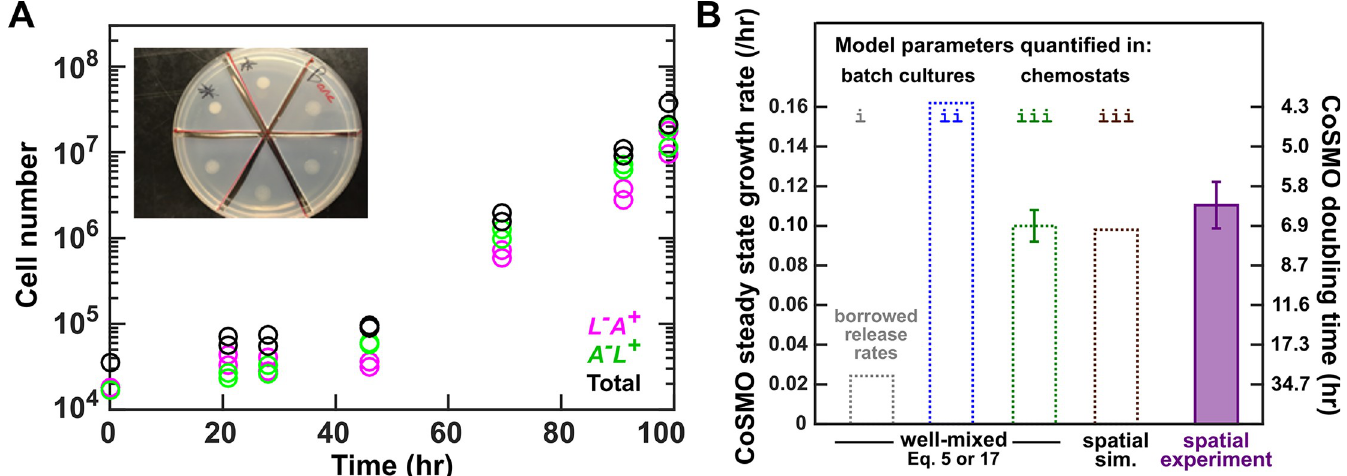
Fig 7. Steady-state CoSMO growth rate can be predicted from parameters measured in chemostats. ( A ) Steady-state CoSMO growth rate on agarose pad. Preconditioned L − A + and A − L + were mixed at approximately 1:1 ratio, and 15 μ L of 4 × 10 4 total cells was spotted on the center of agarose pads (inset), forming an inoculum spot of radius 4 mm (S24A Fig; Methods, “Quantifying spatial CoSMO growth dynamics”). Periodically, cells from pads were washed off into water and subjected to flow cytometry. ( B ) A comparison of model predictions and experiments. Steady-state growth rate of well-mixed CoSMO was calculated from Eq 5 or Eq 17 (with nearly identical results) when we borrowed release rates from a different strain background in starved batch culture (gray; Model i in Fig 1B), when all parameters were measured from the correct strain background in batch cultures (blue; Model ii in Fig 1B), and when all parameters were measured from the correct strain background in chemostats (green; Model iii). A partial differential equation model (i.e., the spatial version of Model iii) was simulated for spatial CoSMO under various experimental configurations, yielding similar predictions on spatial CoSMO growth rate (S23 Fig; S6 Code; S7 Code). The average value was plotted here (brown). In simulations, CoSMO grew at a similar rate in a spatially structured environment as in a well-mixed environment. This is because in spatial CoSMO, concentrations of metabolites eventually became uniform in the agarose and in the community (S25 Fig) and because the two strains formed small (tens of micrometers) patches that were intermixed [32]. The green error bar (95% confidence interval) was calculated from uncertainties in parameter estimations (i.e., 2 SEMs in Table 1) via the method of error propagation (Methods, “Calculating steady-state community growth rate”). Under various experimental configurations (Methods, “Quantifying spatial CoSMO growth dynamics”), steady-state CoSMO growth rates were similar, and the average value and 2 standard deviations from 11 independent experiments were plotted (purple; S4 Table). All data can be found in S7 Data. CoSMO, Cooperation that is Synthetic and Mutually Obligatory; SEM, standard error of the mean; sim., simulation.